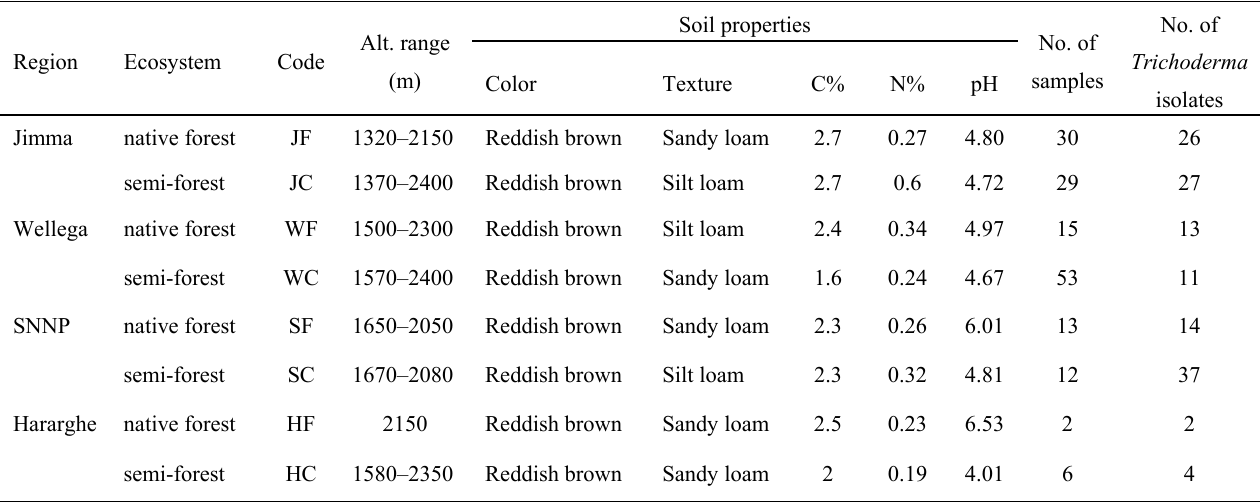
Table 1. Description of sampled areas and physical and chemical properties of